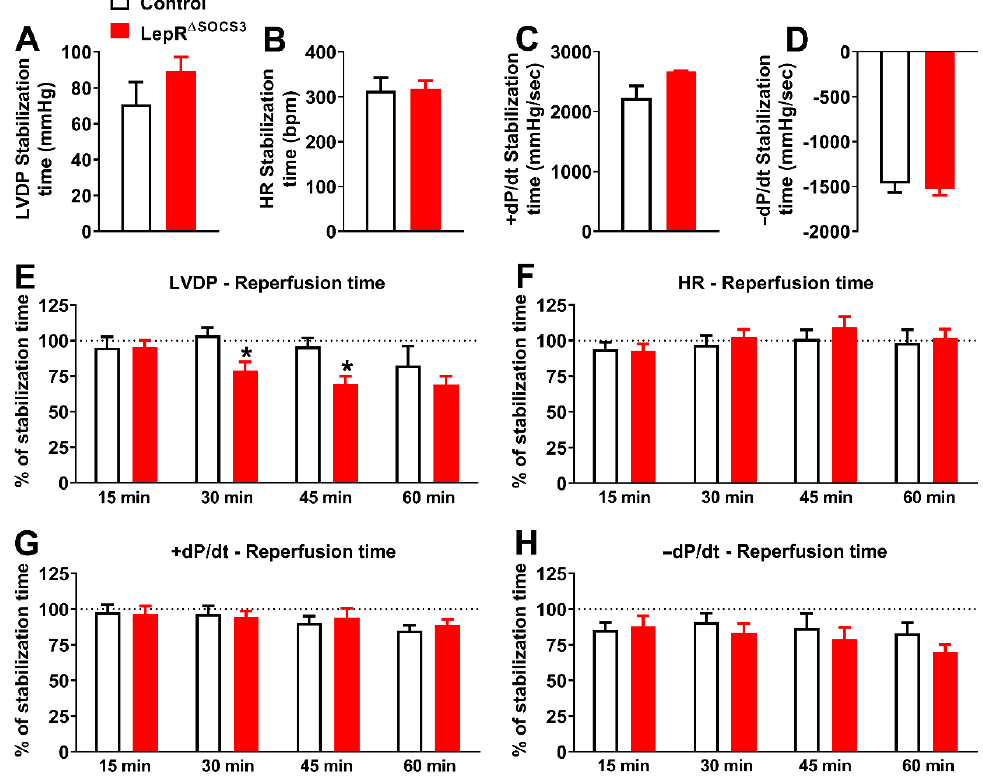
Figure 7. Impairment of post-ischemic cardiac functional recovery in young adult LepR Δ SOCS3 mice. ( A – D ) Baseline cardiac function including left ventricular developed pressure (LVDP), heart rate (HR), first derivative of the positive (+dP/dt) and negative ( − dP/dt) ventricular pressure in young adult control ( n = 6) and LepR ∆ SOCS3 ( n = 5) mice. ( E – H ) Temporal analysis of cardiac parameters at 15, 30, 45 and 60 min of reperfusion in young adult mice. Mean ± SEM. * p < 0.05 control vs. LepR ∆ SOCS3 (post-hoc test repeated measures two-way ANOVA).